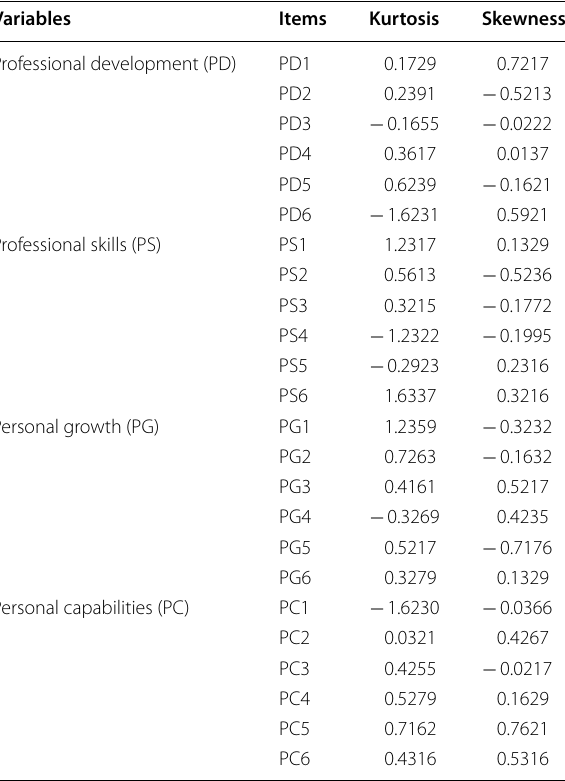
Table 4 Skewness and kurtosis test Source : developed for the study